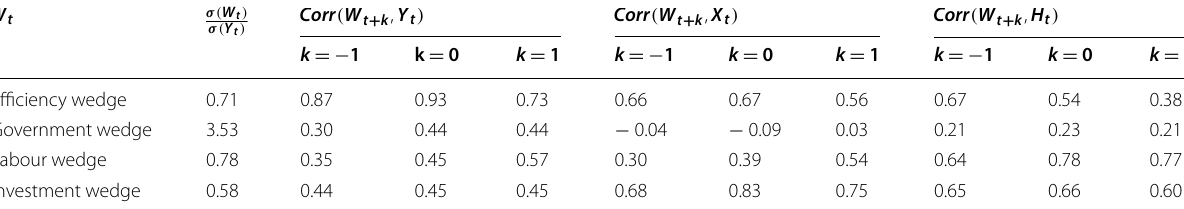
Table 2 Wedge properties (1980Q1–2016Q3)